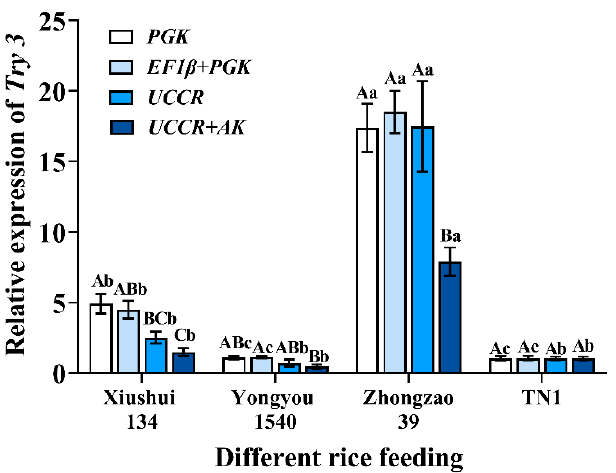
Figure 4. Expression of Try3 gene under different rice feeding using validated reference genes for data normalization. Four reference gene combinations ( PGK , EF1 β + PGK , UCCR , UCCR + AK ) were used for the normalization. The data in the figure were the mean ± standard error. Different lowercase letters indicate that, after normalization with the same reference gene, there was a significant difference in the expression level of Try3 in larvae of C. medinalis feeding on different rice varieties (Tukey’s HSD- p < 0.05). Different uppercase letters indicate that there were significant differences in the normalization results of each reference gene (Tukey’s HSD- p < 0.05).